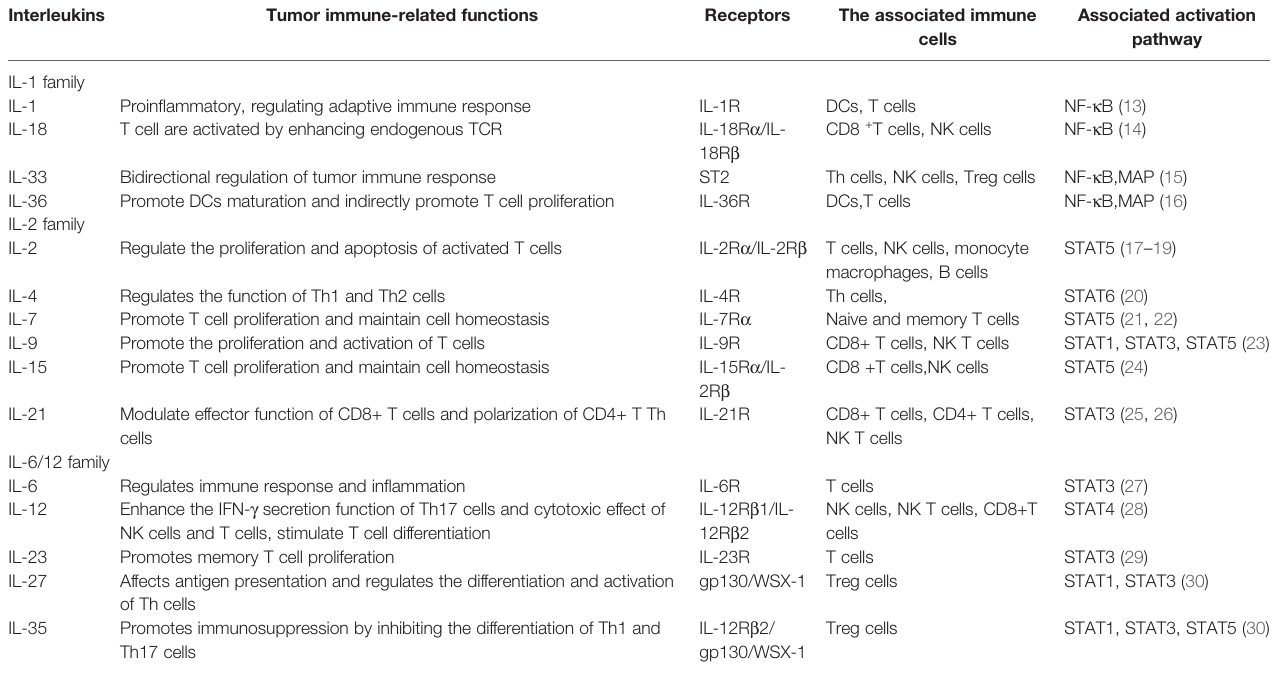
TABLE 1 | Summary of cytokines related to tumor immunotherapy in the interleukin family.